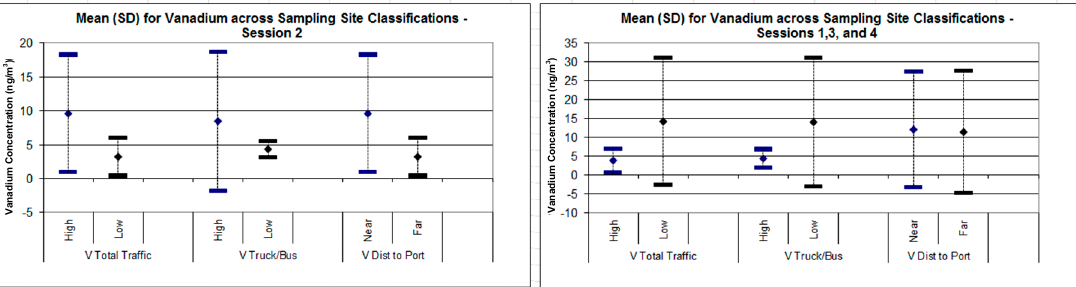
Figure 6. Boxplots of vanadium concentrations versus high/low source density, for Session 2 (northeasterly winds) versus Sessions 1, 3, and 4 (southwesterly winds).